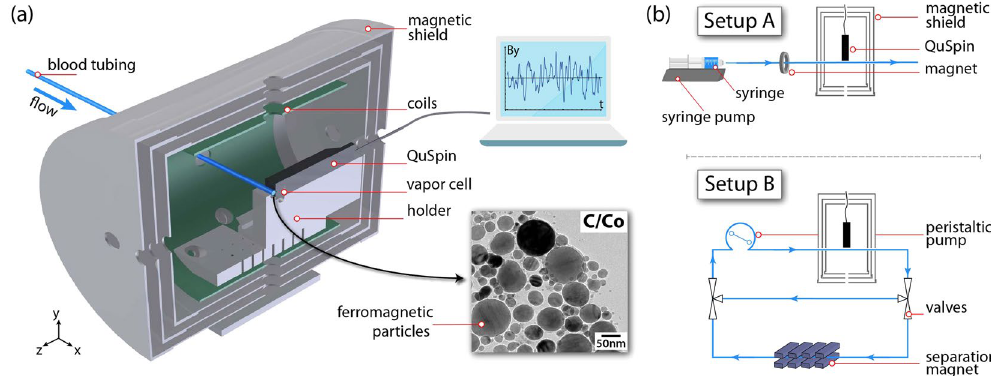
Figure 1. ( a ) Schematic diagram of the in-line magnetic sensor used for ferromagnetic particle detection inside a magnetic shield (QuSpin is the atomic magnetometer). ( b ) Diagrams for the different setups used in this work: Setup (A) uses a syringe pump for fluid displacement. Particles are additionally pre-magnetized with a ring magnet before passing the sensor. In setup (B) solvents are circulated using a peristaltic pump. The fluid can be circulated either in a closed loop without magnetization, or, by switching the three-way valves, through a high- gradient magnet that allows for the magnetic particle